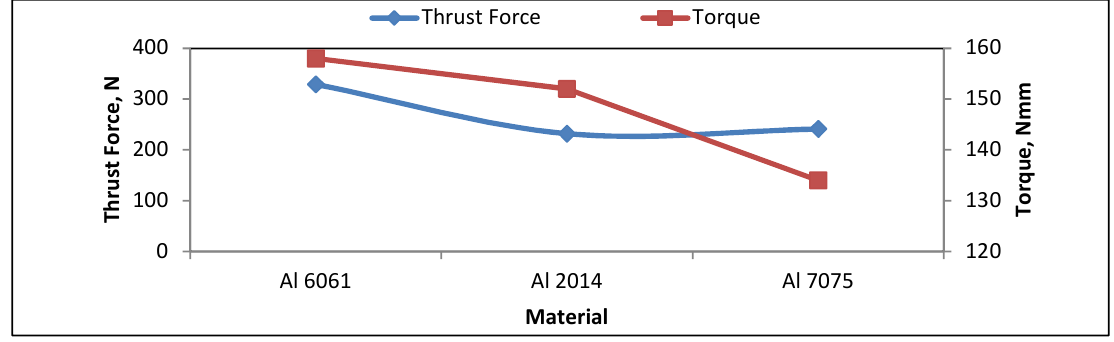
Fig. 19. Effect of thrust force and torque during drilling by the change of work piece